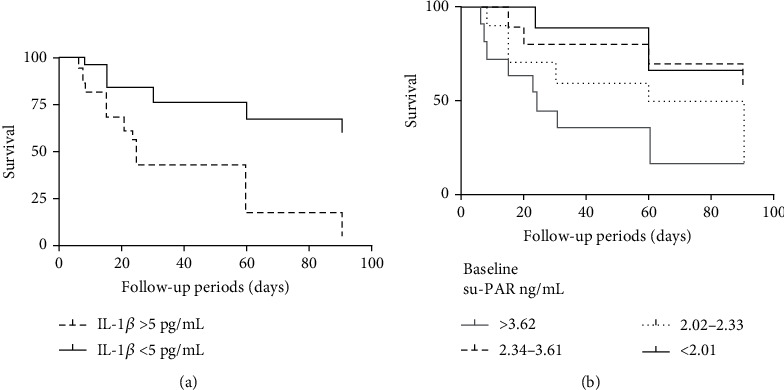
Kaplan–Meier based on serum levels of IL-1β (a) and su-PAR (b) estimates the 3-month mortality of AE-IPF: (a) log-rank test (p < 0.001) (IL‐1β > 5 pg/mL, IL‐1β < 5 pg/mL); (b) log-rank test (p1 = 0.012) (su‐PAR > 3.627 ng/mL, su‐PAR < 2.01 ng/mL).